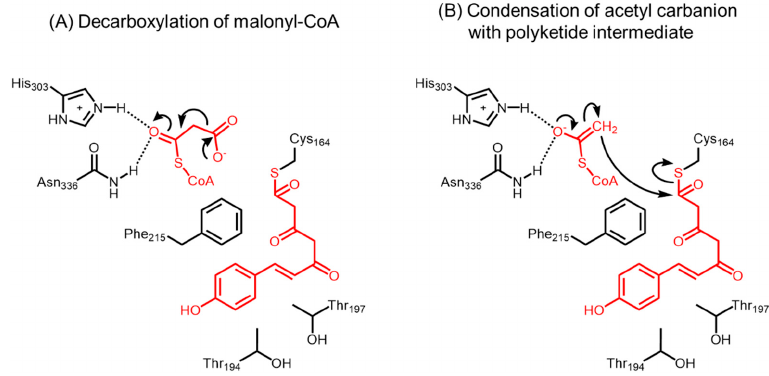
Figure 17. ( A ) Decarboxylation of the extender malonyl-CoA is catalyzed by His303 and Asn336 in alfalfa CHS. Phe215 is thought to orient the terminal carboxylate of malonyl-CoA and aid in the reaction; ( B ) The acetyl carbanion subsequently undergoes a condensation with the enzyme-bound triketide